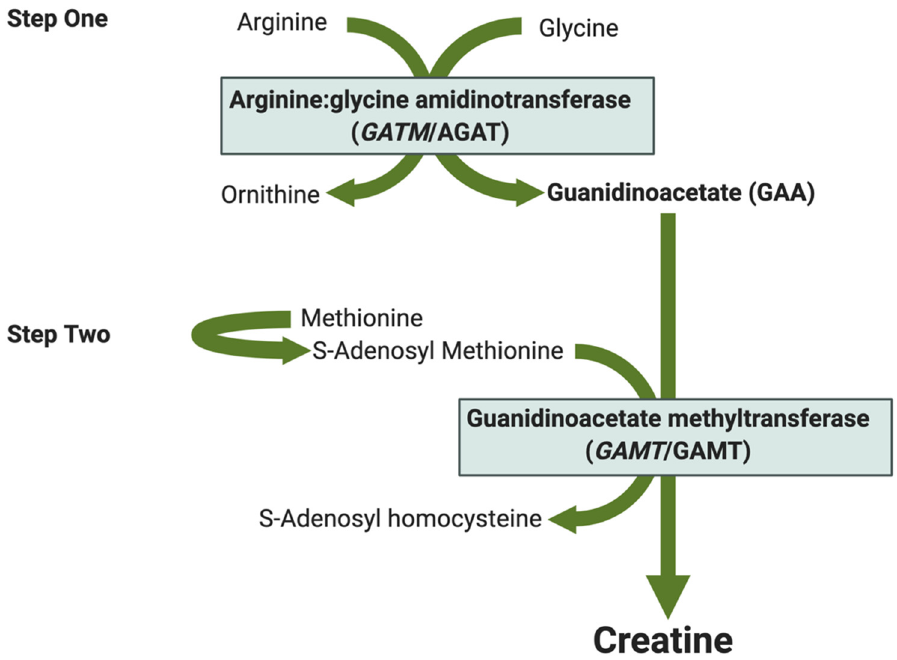
Figure 2. Schematic of de novo creatine synthesis. Step one—Arginine and glycine combine to form guanidinoacetic acid (GAA) and ornithine in a reaction catalyzed by arginine:glycine amidinotrans- ferase (AGAT translated from the GATM gene). Step two—GAA is methylated to form creatine and S-Adenosyl homocysteine. S-adenosyl methionine (SAM) is the primary methyl donor for this reac- tion catalyzed by guanidinoacetate methyltransferase ( GAMT /GAMT).